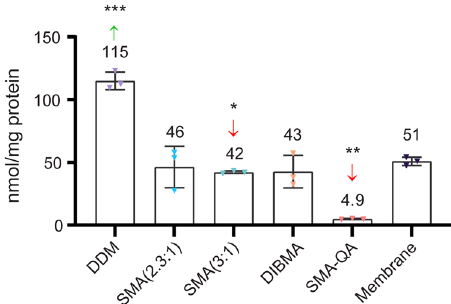
Fig. 6 Cholesterol (nmol per mg of protein) in Jurkat membranes and solubilized membranes using the Amplex ™ Red Cholesterol Assay Kit (triplicate measurements). Error bars represent ±S.D. Signi fi cant differences compared with the membrane (upon individual t tests) are denoted as * p < 0.05, ** p < 0.01, *** p